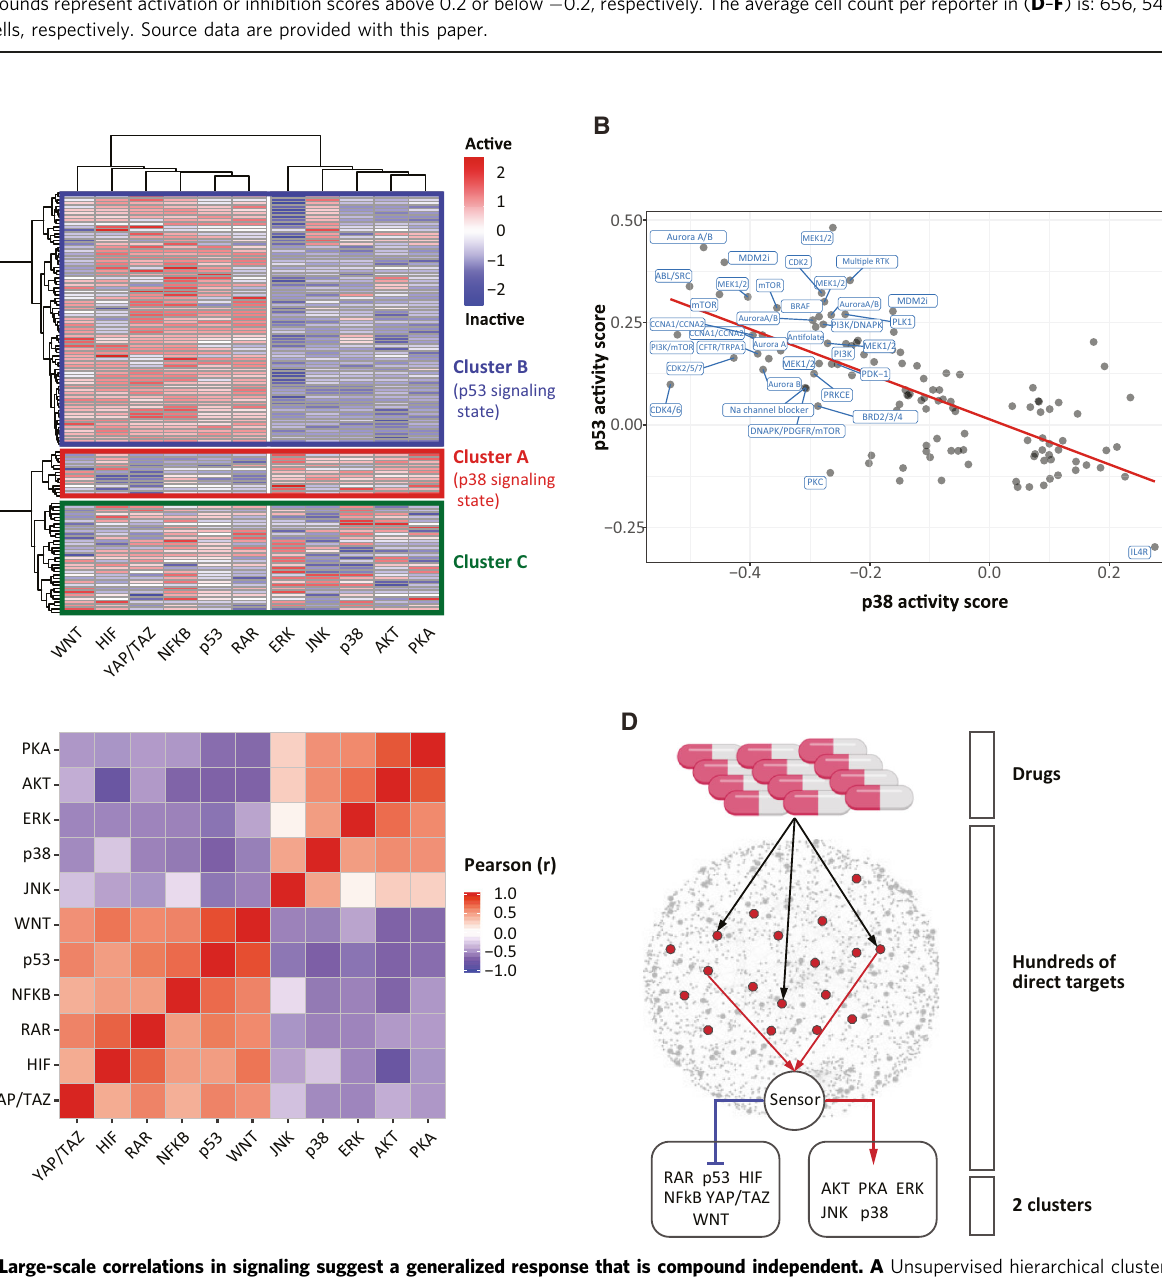
Fig. 3 Large-scale correlations in signaling suggest a generalized response that is compound independent. A Unsupervised hierarchical clustering of A375 signalome cells treated by 122 active drugs according to their activity scores. Due to technical error, Geminin reporter was not measured for all drugs and was thus discarded. Results from all 12 reporters can be seen in Supplementary Fig. 4I for the subset of drugs that for which Geminin data are available. B Scatter plot showing the correlation between the activities of the p38 and p53 reporters after 48 h of treatment with 122 active drugs. C Heatmap showing the pairwise Pearson correlations between the different A375 Signalome clones, after 48 h of treatment with 122 active drugs. D A model proposing how drugs with different mechanisms may converge into two major signaling states. While each of the drugs has different targets, many of the targets affect the same sensing mechanism that later governs the p53- vs p38-signaling states. Source data are provided with this